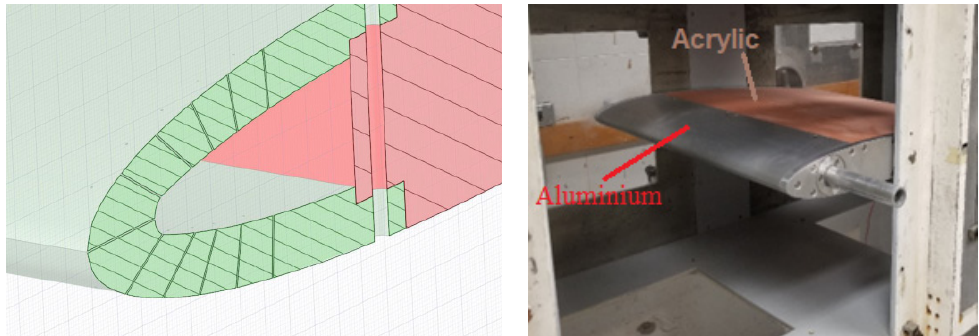
Figure 5. Two different materials of the model: aluminium alloy (hollowed out) and acrylic.